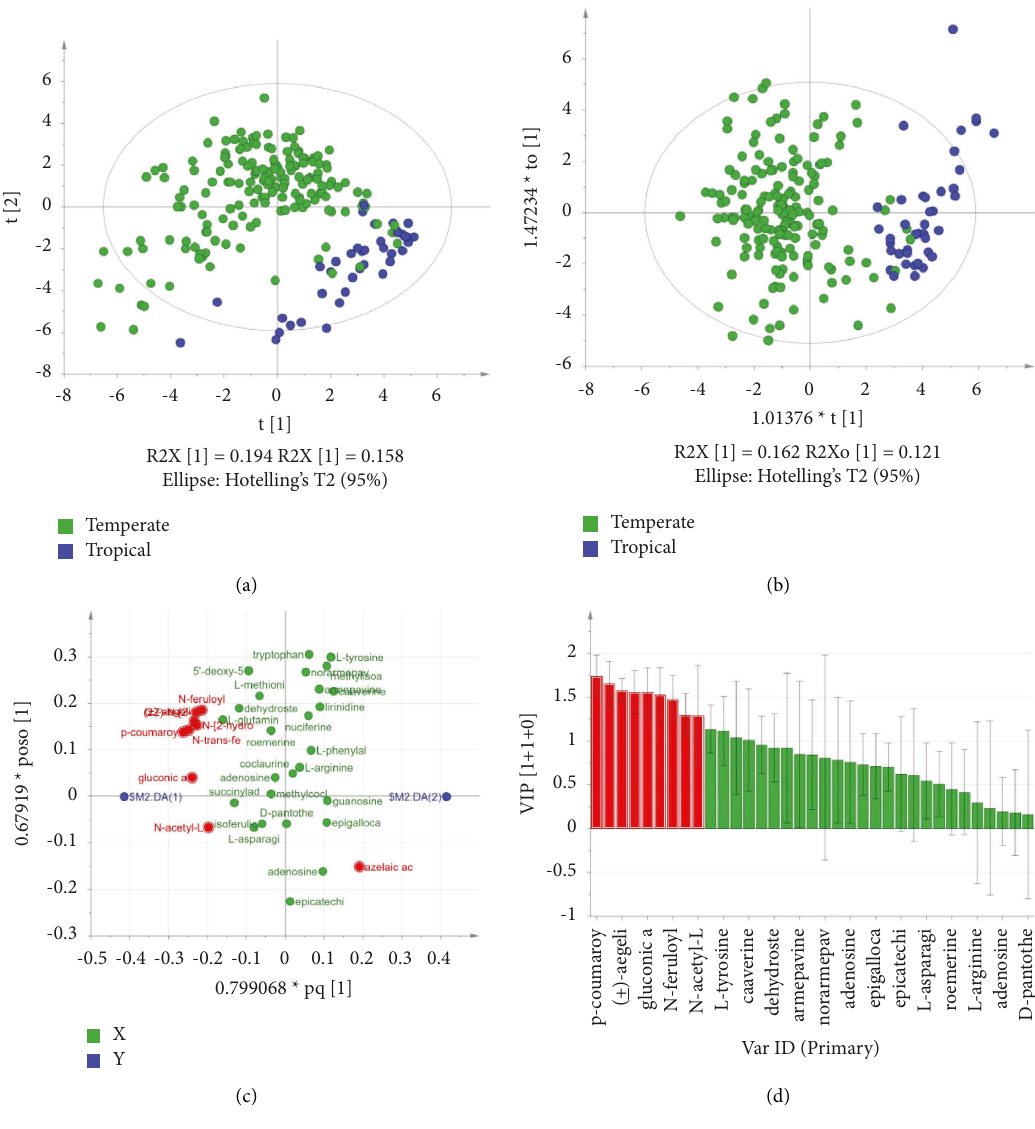
Figure 2: Relationship between secondary metabolites (polyphenols, amino acids, and alkaloids) and their ecotype in 212 sacred lotus rhizome cultivars (significant compounds are shown in red). (a) PCA score plot of 212 sacred lotus rhizomes with different ecotypes. (b) OPLS-DA score plot of 212 sacred lotus rhizome with different ecotypes. (c) S-plot of 48 identified and quantified compounds. (d) VIP distribution of the 48 identified and quantified